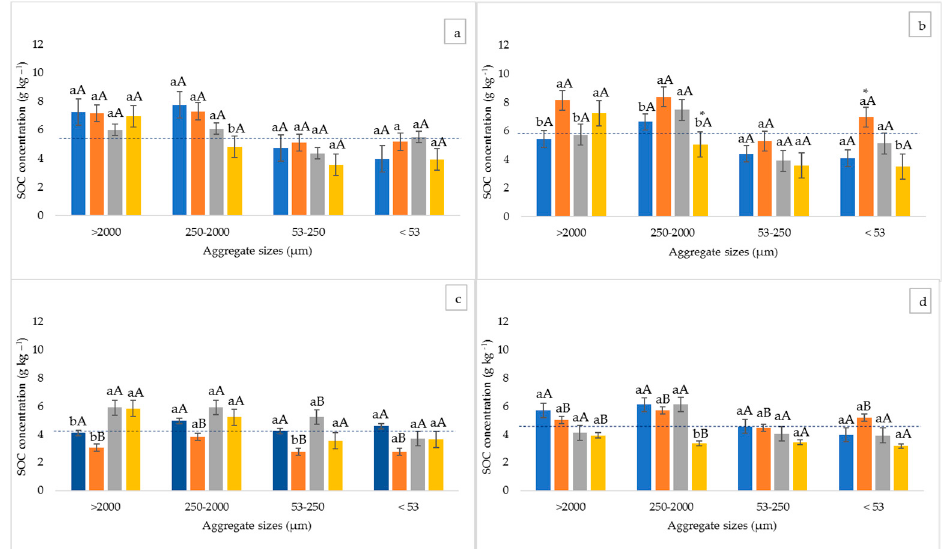
Figure 6. Aggregate-associated soil organic carbon (SOC) concentration (g kg − 1 ) in different sizes of soil water-stable aggregates for conventional-tillage (CT; blue bars); saffron (D-S; orange bars); oats (D-O; grey bars) and lavender (D-L; yellow bars) treatments at ( a ) 0–10 cm depth (2018), ( b ) 0–10 cm depth (2021), ( c ) 10–30 cm depth (2018) and ( d ) 10–30 cm depth (2021). The different lowercase letters above the error bars for the same soil layer indicate significant differences between managements at p < 0.05. Different capital letters are indicating differences in depth. Each cultivation system (*) represents significant differences with respect to the olive monocrop conventional tillage system in 2018 (control treatment) by Dunnett’s test (* p < 0.05). Missing asterisks denote non-significant differences.